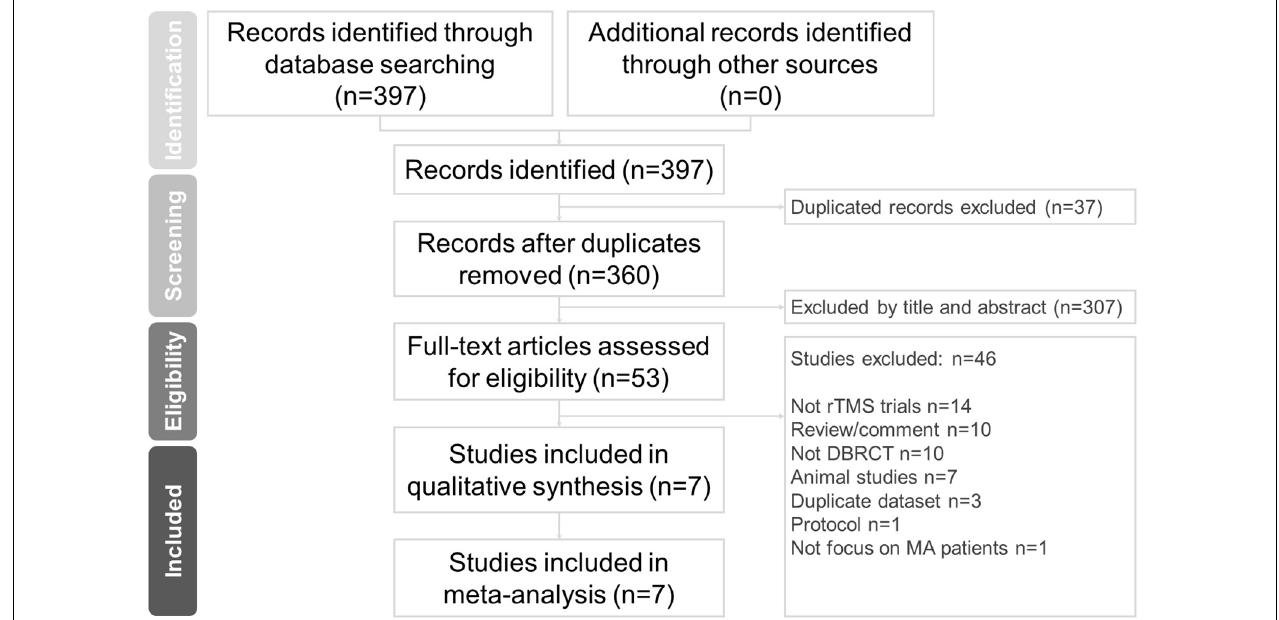
FIGURE 1 | PRISMA flow diagram for the identification of included studies. Database: PubMed ( n = 312), Cochrane Central Register of Controlled Trials ( n = 85), Cochrane Database of Systematic Reviews ( n = 0). Keyword: (methamphetamine OR methylamphetamine) AND (repetitive transcranial magnetic stimulation OR rTMS OR brain stimulation OR theta-burst). Date: date available to Mar 2022. DBRCT, double-blind randomized placebo-controlled trial; MA, methamphetamine; rTMS, repetitive transcranial magnetic stimulation.